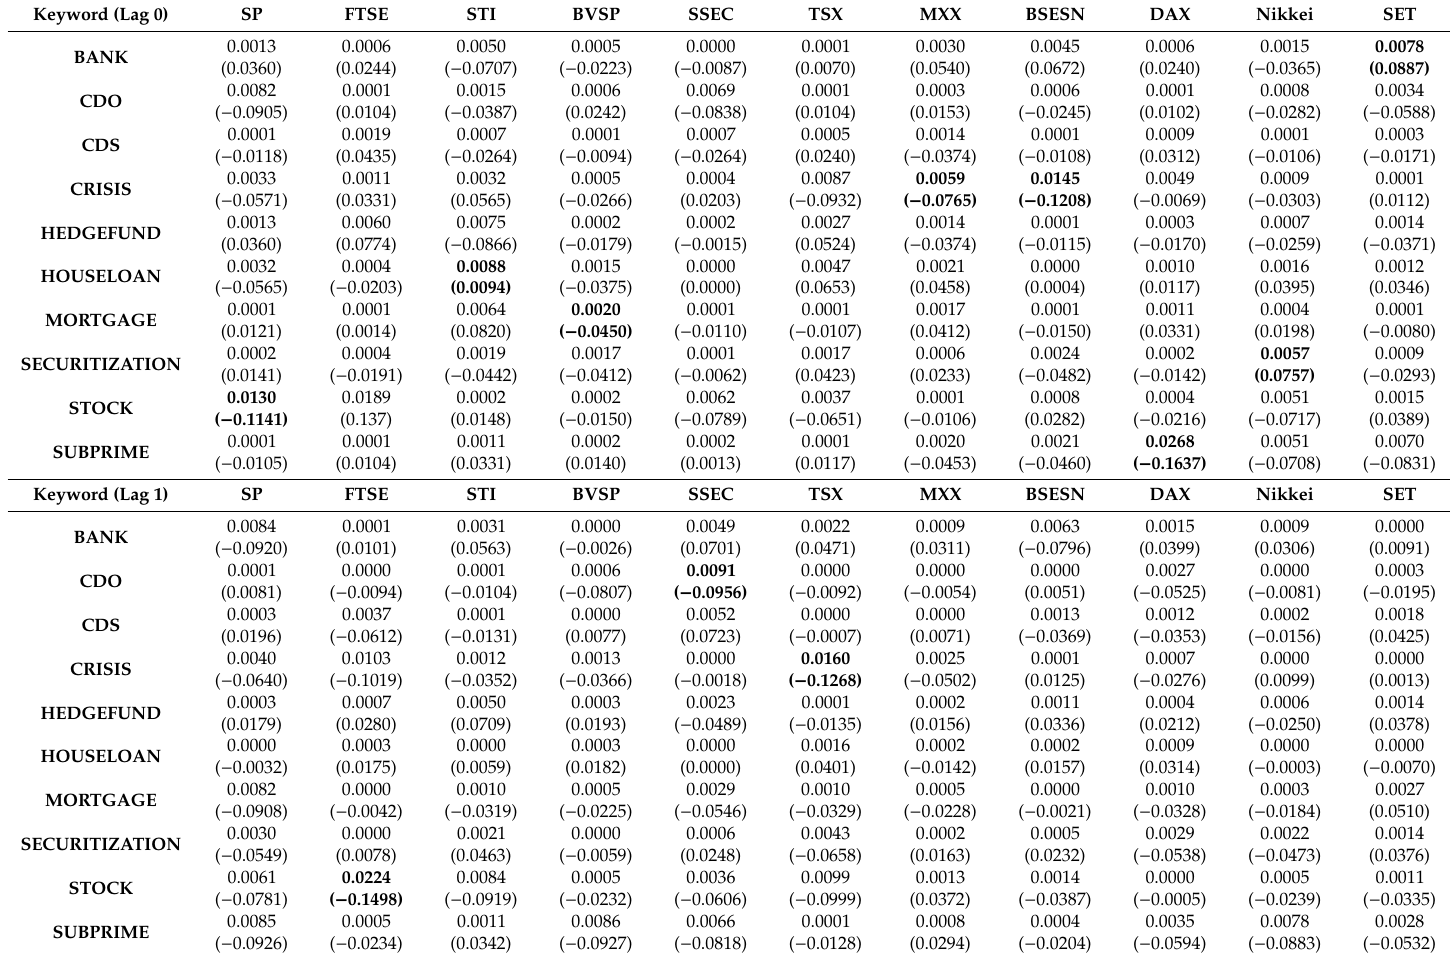
Table 1. Estimated R-squared and correlation between each Google index and the corresponding stock